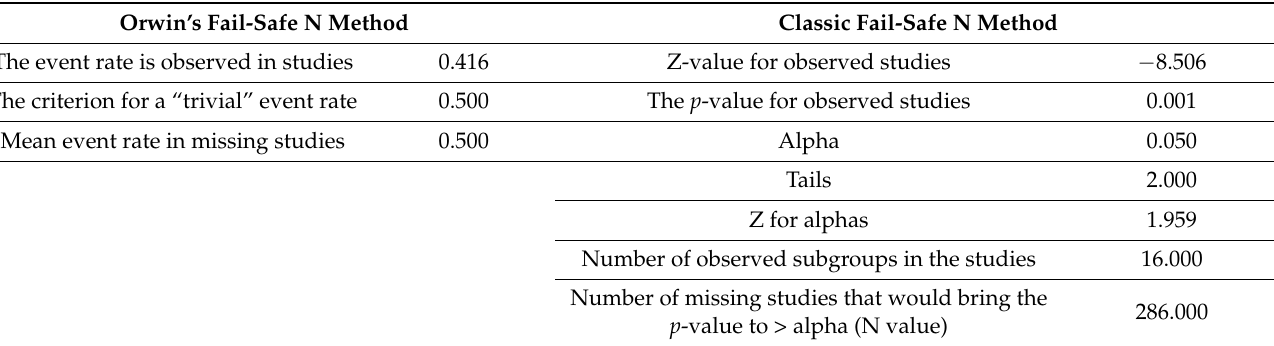
Table 3. Orwin’s and Classic Fail-Safe N